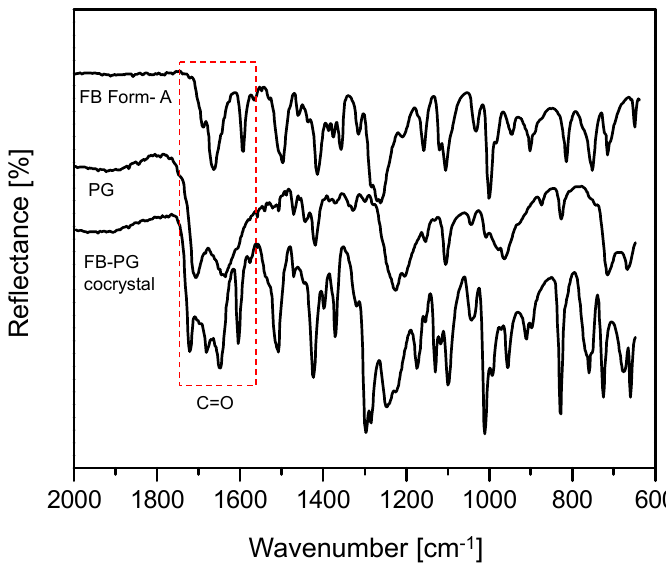
Figure 6. FT-IR spectra of FB-PG cocrystal, FB form-A, and PG.